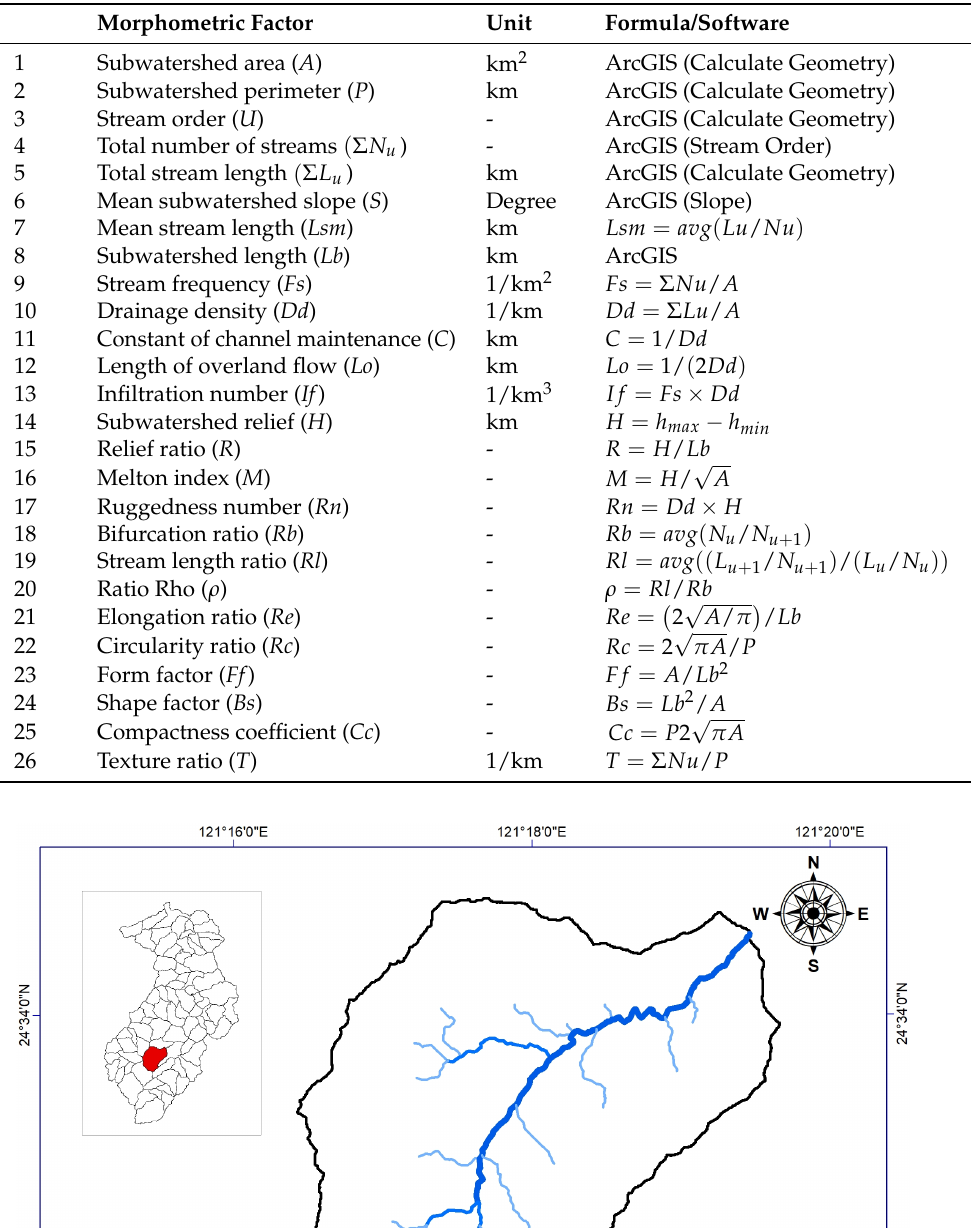
Table 1. The morphometric factors used in this study.